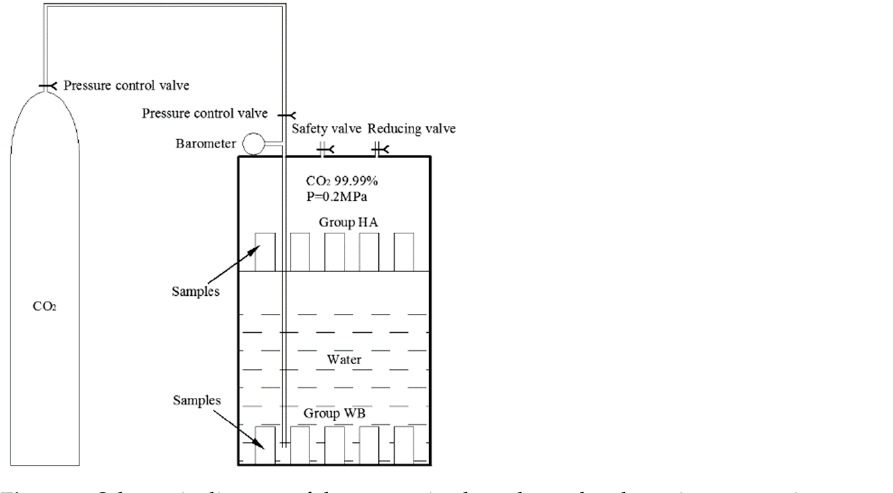
Figure 1. Schematic diagram of the pressurized accelerated carbonation test equipment.